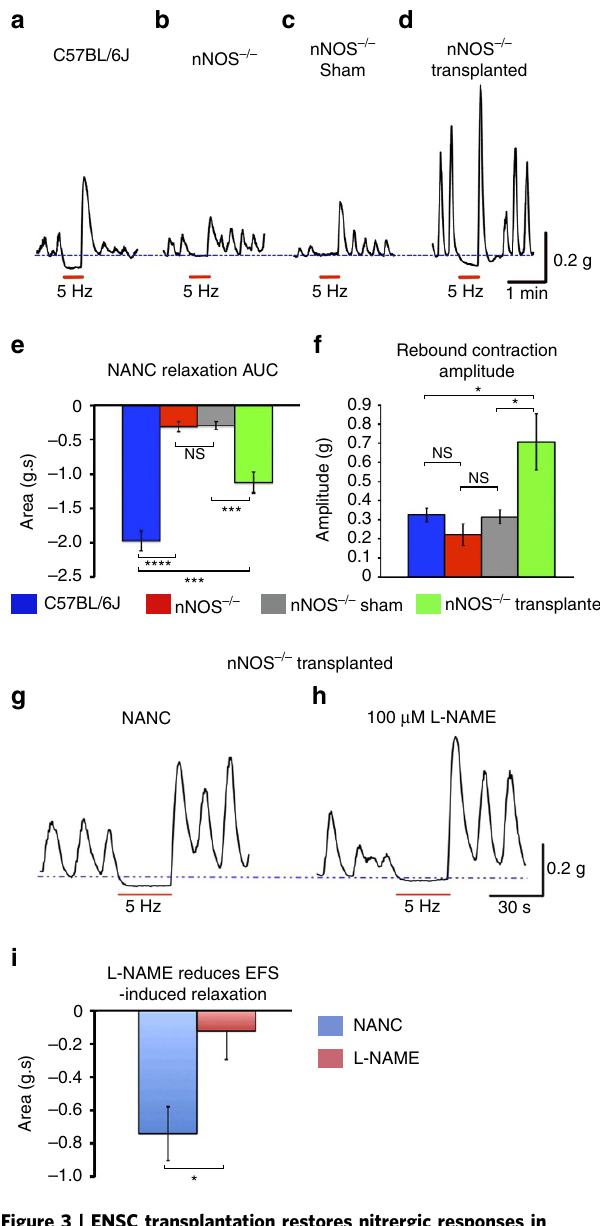
Figure 3 | ENSC transplantation restores nitrergic responses in nNOS (cid:2) / (cid:2) distal colon. ( a – d ) Representative traces of organ bath contractility in the presence of NANC demonstrating the response, in distal colonic segments, to EFS. ( a ) In response to EFS C57BL/6J distal colon demonstrates nitrergic relaxation, seen as relaxation below basal tension (dotted line). ( b , c ) nNOS (cid:2) / (cid:2) non-transplanted and sham-operated animals display a loss of this response. ( d ) Transplanted nNOS (cid:2) / (cid:2) mice display a partial restoration of the response at 4 weeks post transplantation. ( e , f ) Quantification of EFS-induced relaxation (area under curve, e ) and rebound contraction ( f ) in C57BL/6J (blue bars, n ¼ 5), nNOS (cid:2) / (cid:2) (red bars, n ¼ 5), sham-operated nNOS (cid:2) / (cid:2) (grey bars, n ¼ 5) and transplanted nNOS (cid:2) / (cid:2) (green bars, n ¼ 5) distal colon. **** P r 0.0001, ** P r 0.01, * P r 0.05, by Student’s t -test. ( g – i ) Representative traces of organ bath contractility in transplanted nNOS (cid:2) / (cid:2) colon in the absence or presence of the nitric oxide synthase antagonist L-NAME. ( i ) Summary data of the effect of L-NAME on the EFS-induced nitrergic response in transplanted nNOS (cid:2) / (cid:2) distal colon ( n ¼ 4). * P r 0.05 by Student’s t -test. Error bars represent mean ± s.e.m. in all